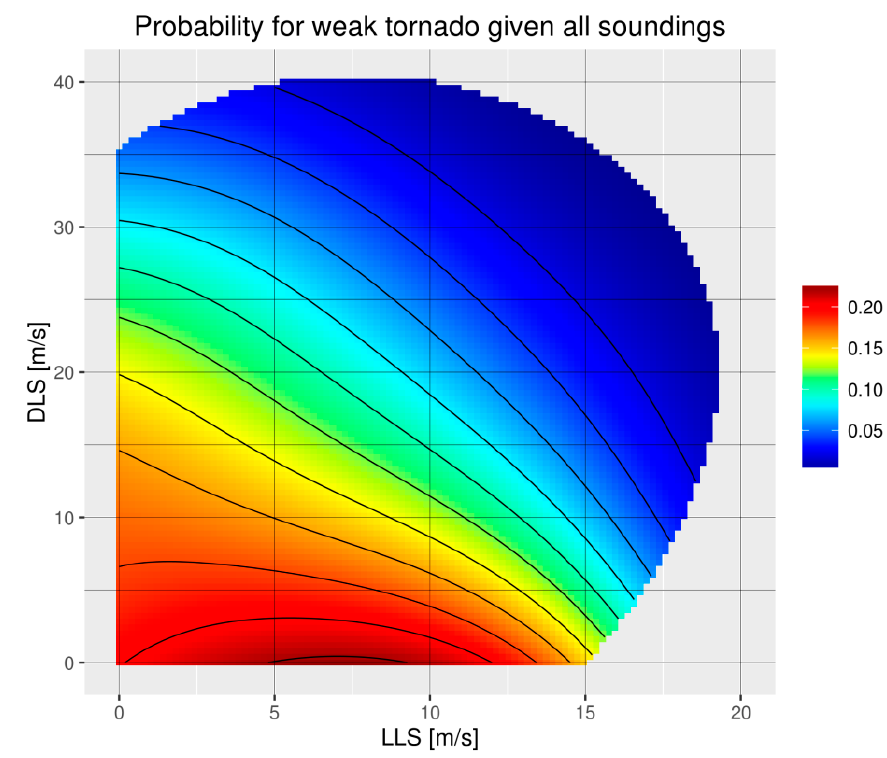
Figure 14. As in Figure 9, except for weak tornadoes.